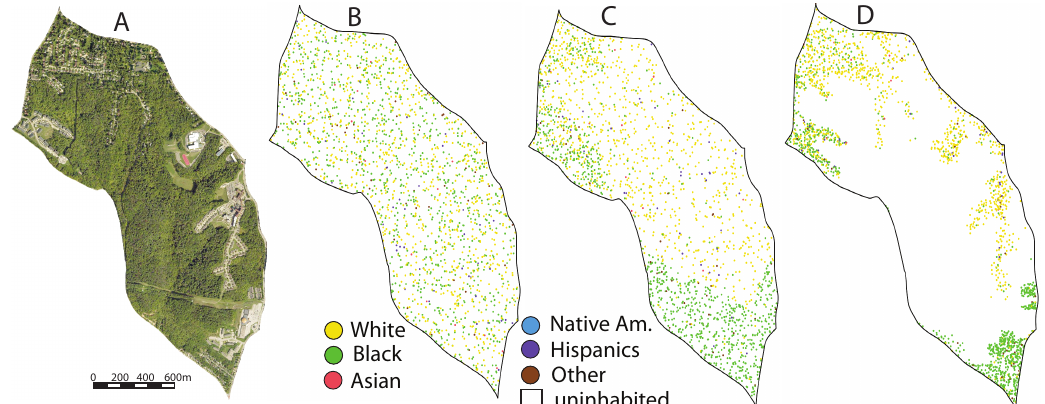
Figure 5. Comparison of racial dot maps of Census Tract Number 008400 in Cincinnati, Hamilton County, OH, using different areal units. ( A ) An aerial image of the tract shows the distribution of inhabited and uninhabited areas; ( B ) dot map based on the Census tract; ( C ) dot map based on Census blocks; ( D ) dot maps based on grid